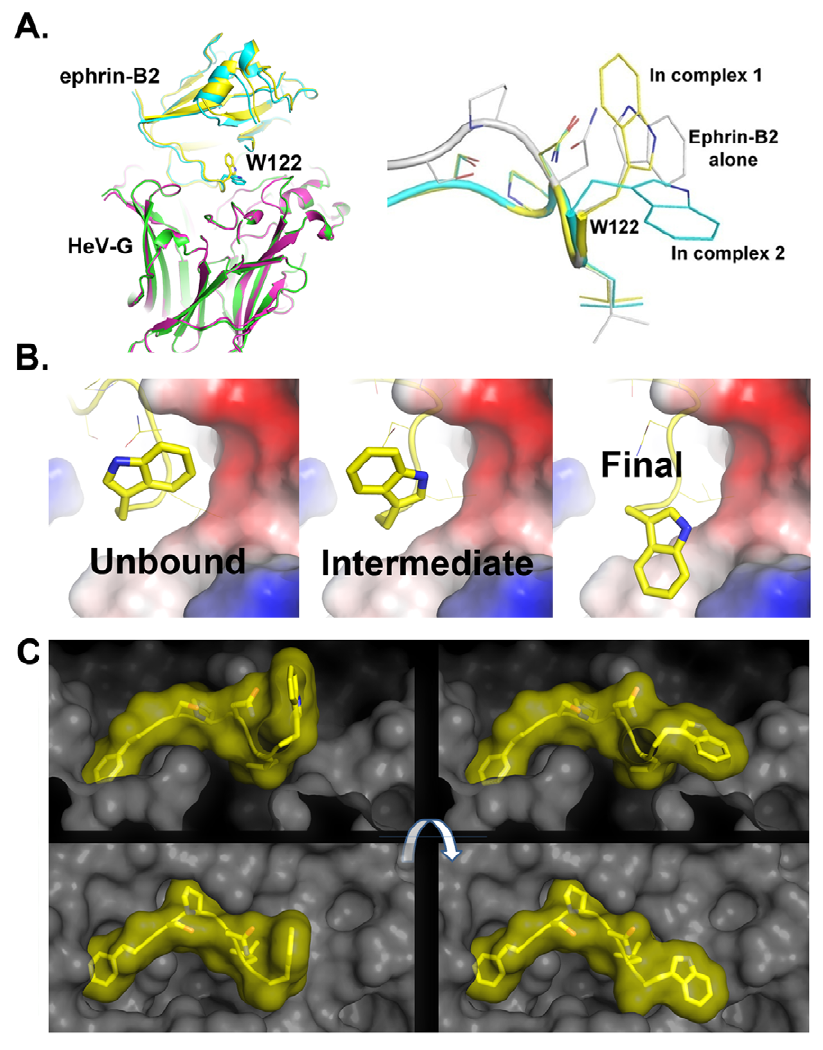
Figure 6. The ephrin-B2 W122 ‘‘latch’’. Two rotameric W122 (ephrin-B2) conformations in the HeV-G/ephrin-B2 complex, both of which are distinct from the W122 conformation in unbound ephrin-B2. Ephrin-B2 is shown in silver in the unbound state, and in yellow or cyan in the two complexes with HeV-G (A). W122 transforms from the initial unbound conformation to an intermediate conformation upon binding to HeV-G due to steric and electrostatic constrains, then adopts its final conformation via stabilizing van der Waals interactions with HeV-G. W122 is shown as yellow sticks. G is shown as a surface colored according to its electrostatic potential (B). ‘‘Latch up’’ and ‘‘latch down’’ conformations of ephrin-B2-W122 mediate the association and dissociation of the HeV-G/ephrin-B2 complex. Ephrin-B2-W122 is shown in yellow, HeV-G - in grey